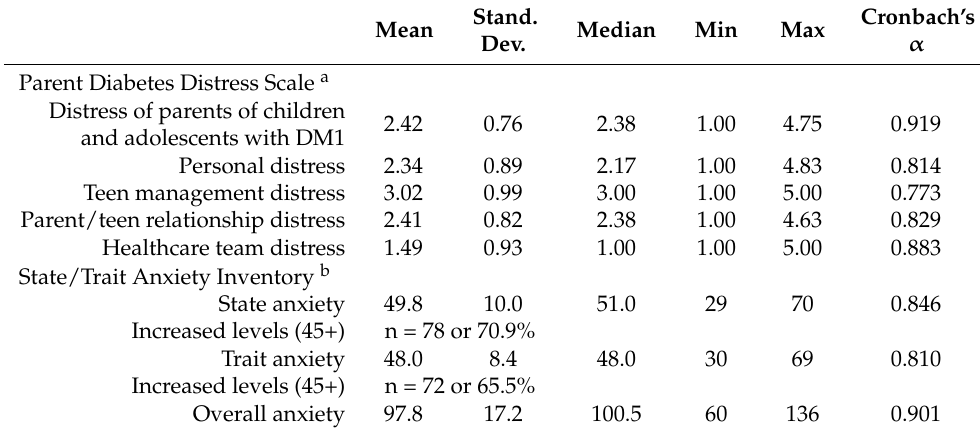
Table 3. Subscale scores of Parent Diabetes Distress Scale (PDDS) the previous month and Spielberger State/Trait Anxiety Inventory (STAI) of parents of children and adolescents with DM1. Stand. Mean